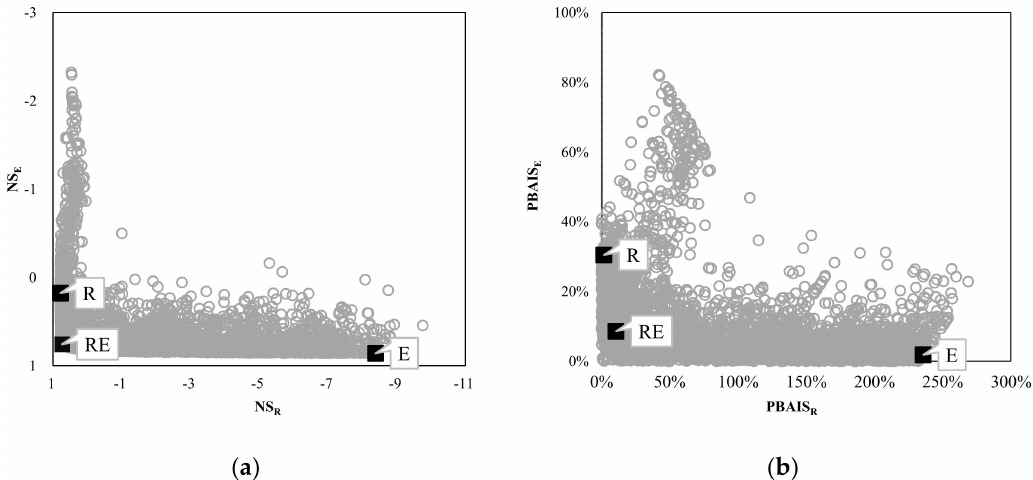
Figure 8. ( a ) Solution distribution in objective space of NS of runoff and evapotranspiration, and ( b ) in objective space of PBIAS of runoff and evapotranspiration from multi-objective calibration for runoff and evapotranspiration.